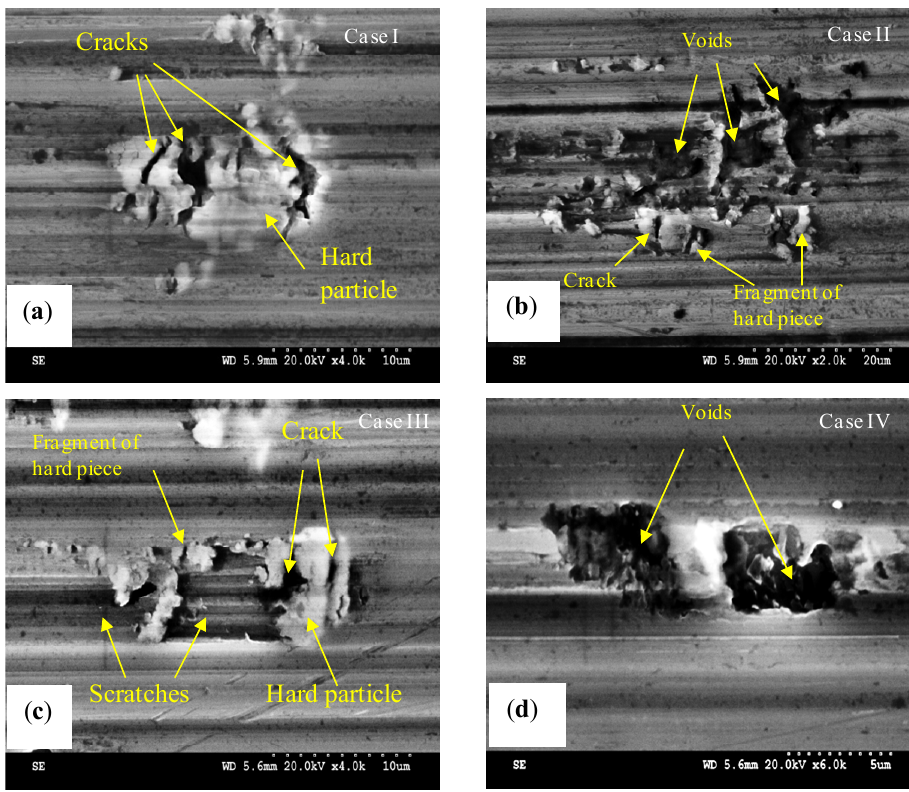
Figure 11. SEM micrographs of the machined surfaces showing ( a ) hard particle cracking; ( b ) smearing; ( c ) cracking and dragging of hard particles and ( d ) voids. ( a ) and ( b ) for Trial #2 and ( c ) and ( d ) for Trial #4.